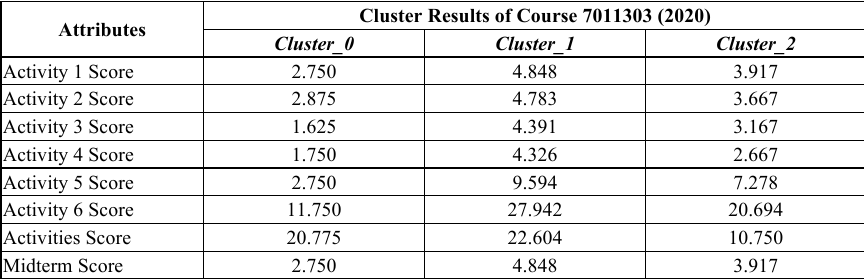
Table 6. Cluster results for course 7011303